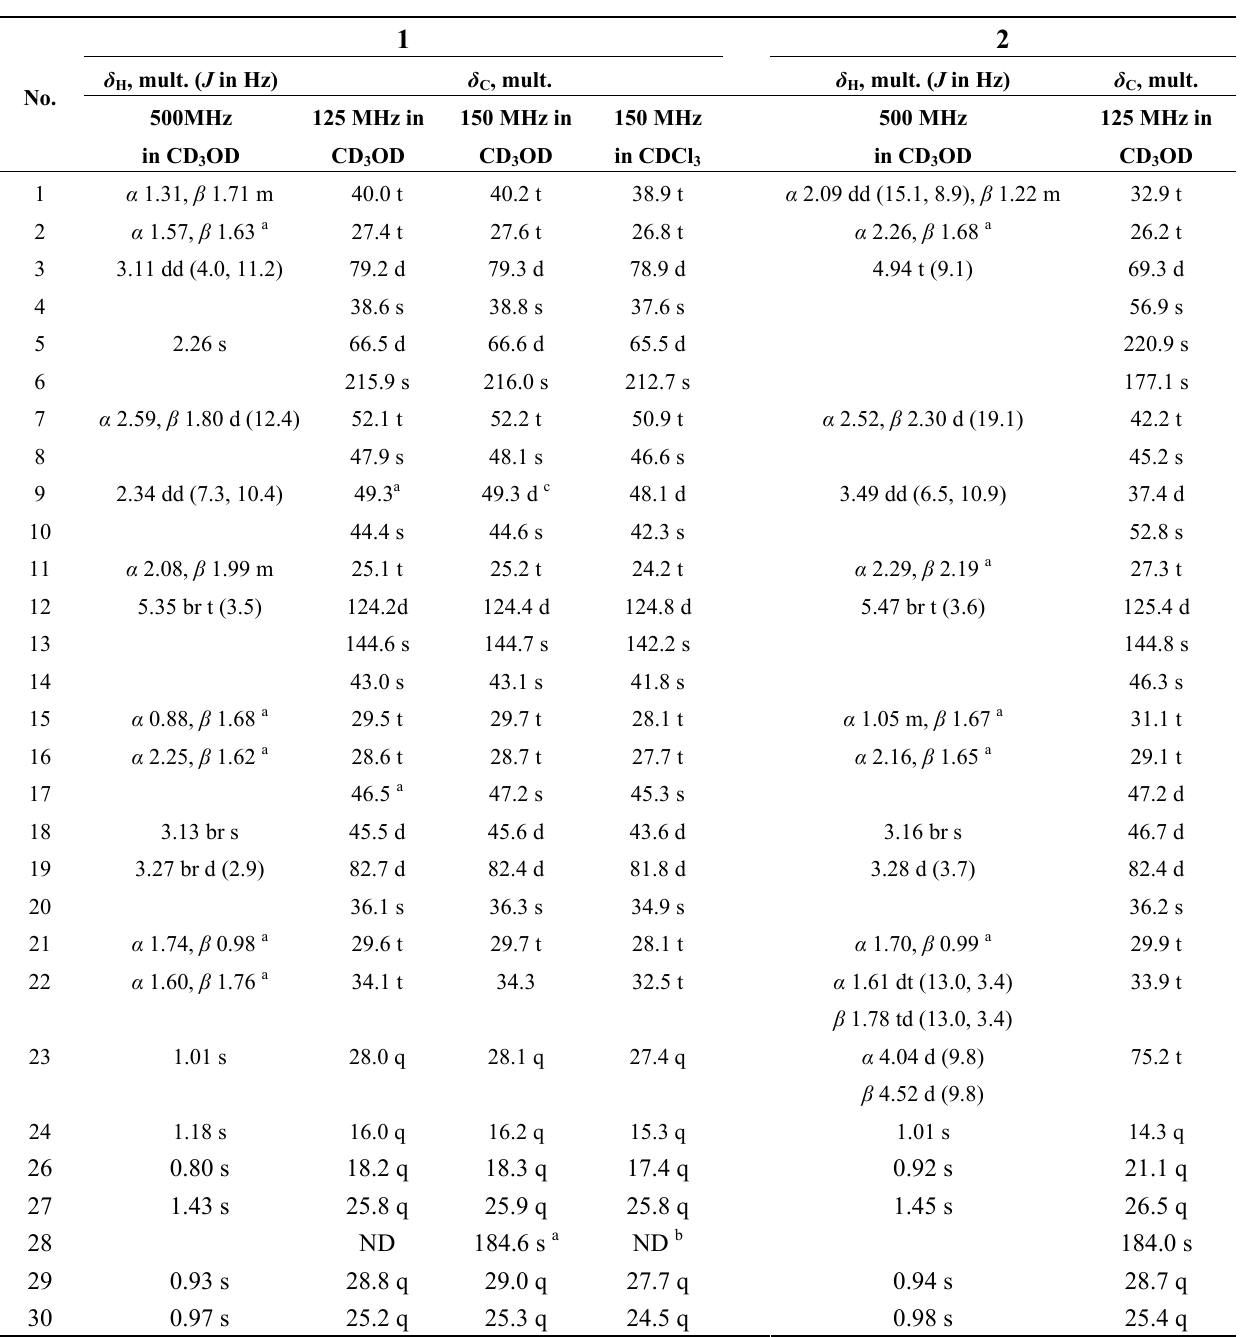
Table 1. 1 H- and 13 C-NMR of 1 and 2 .